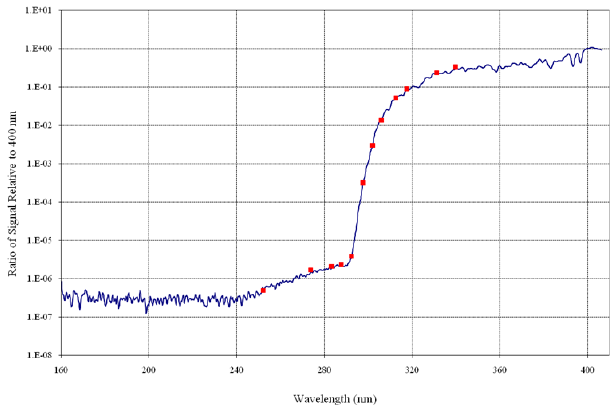
Fig. 15. Zenith sky radiance observed by the SBUV/2 FM#8 in- strument (flown on NOAA-19) during laboratory testing in Octo- ber 2000, normalized to the signal at 400nm. The 12 wavelengths used for normal discrete ozone measurements are indicated by filled squares. Reproduced from Ball Aerospace (2005) with permission of Ball Aerospace and Technology